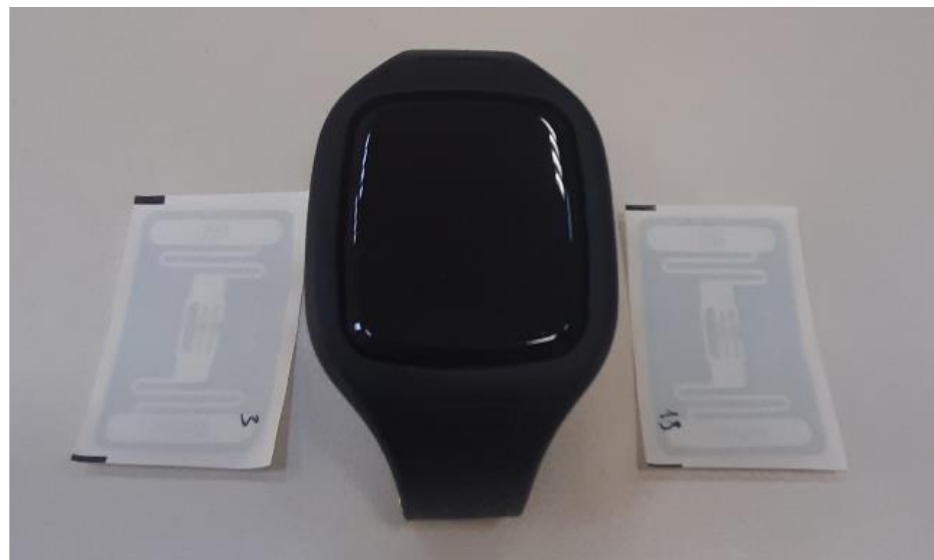
Figure 6. Wearable RFID reader and RFID tags.